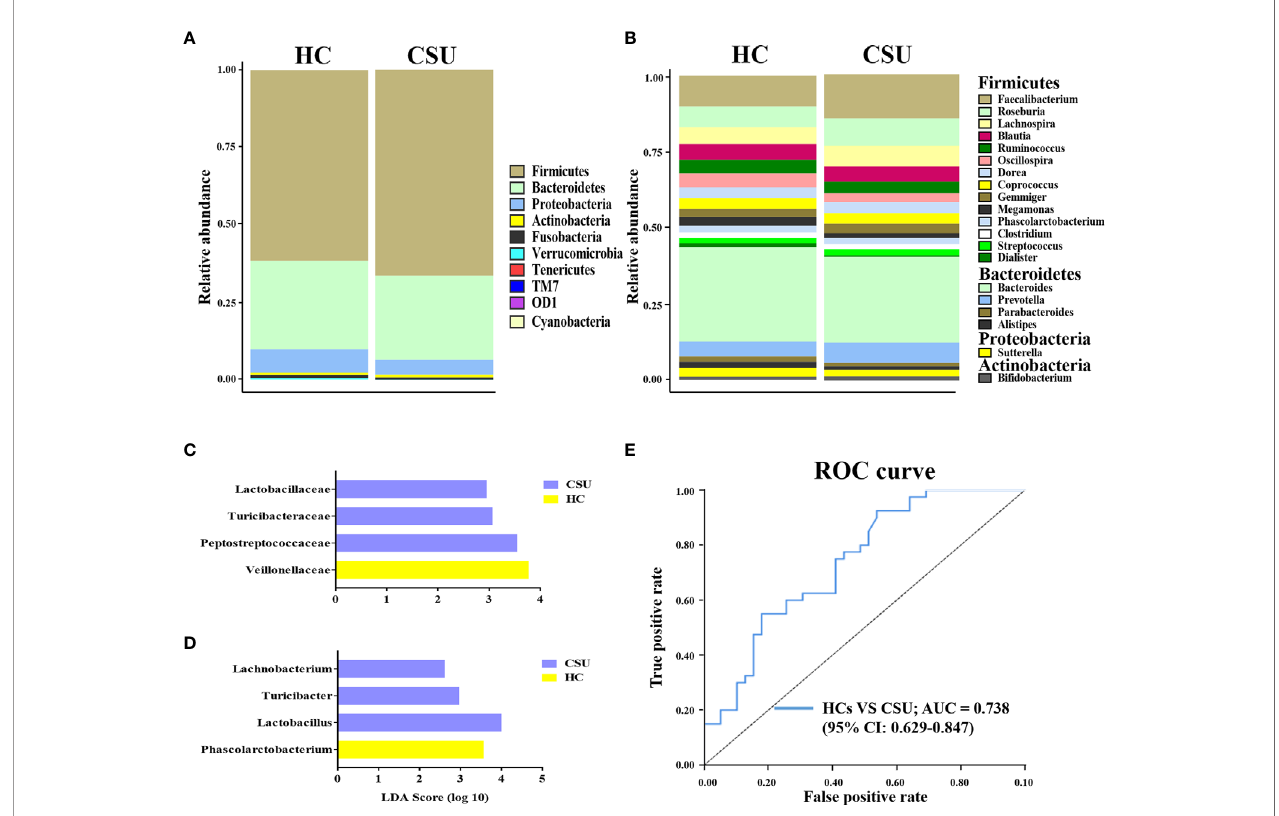
FIGURE 2 | Abundance of fecal bacterial community between patients with chronic spontaneous urticaria (CSU) and healthy controls (HCs). (A, B) Pro fi les of the relative abundance at the phylum (A) and genus (B) levels between the two groups. Only the top 10 phyla and the top 20 genera are shown. (C, D) Linear discriminant analysis (LDA) demonstrated distinct gut bacterial taxa enriched in patients with CSU compared to HCs. (LDA score > 2, p < 0.05). Bacterial taxa that were enriched in fecal samples from patients with CSU ( blue ) and HCs ( yellow ) are shown by the LDA scores at the family (C) and genus (D) levels. (E) Receiver operating characteristic (ROC) curve of the combinations of selected families and genera to identify CSU patients and HCs. The area under the ROC curve (AUC) is shown for the microbial combination predictors with 95%